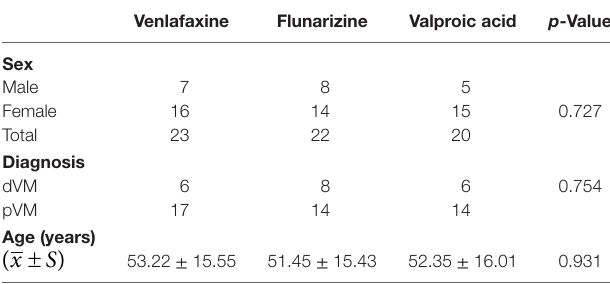
TaBlE 2 | Demographic profile of patients in the study.